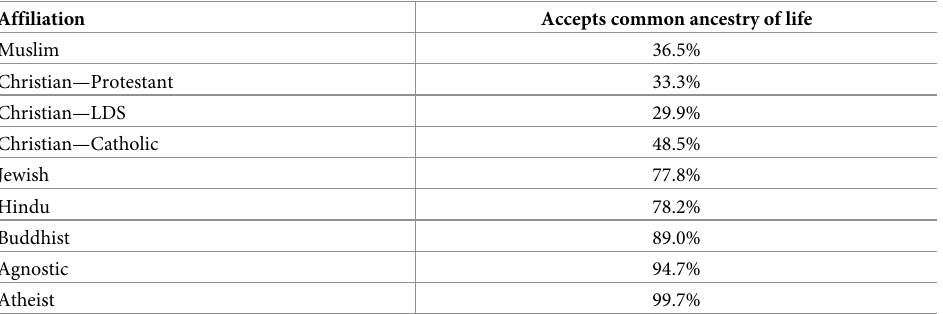
Table 5. Proportion of students that believe life on Earth shares a common ancestor disaggregated by religious affiliation.